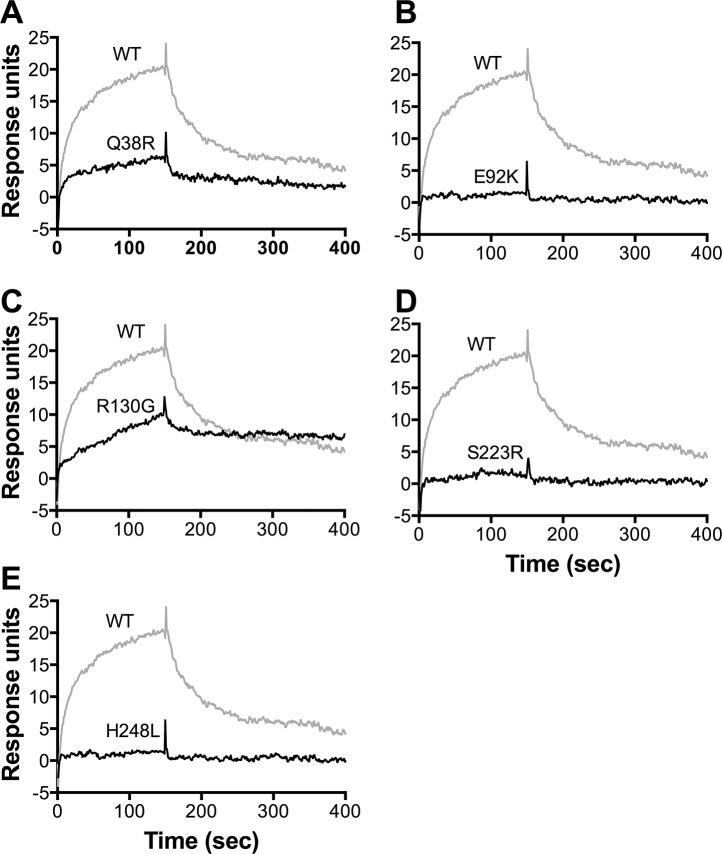
Binding of FHbp to immobilized human FH by surface plasmon resonance.Purified human FH (1500 response units) was coupled to the biosensor chip. Different concentrations (3 to 316 nM) of purified, recombinant FHbp were used to determine equilibrium dissociation constants (Table 1). A. Data for injection of 100 nM of wild-type (WT) FHbp (grey line) or Q38R mutant (black line) are shown. B-E. Data for E92K, R130G, S223R and H248L mutants are shown with WT FHbp (same data as in Panel A). Binding equivalent to two response units was considered as the limit of detection.